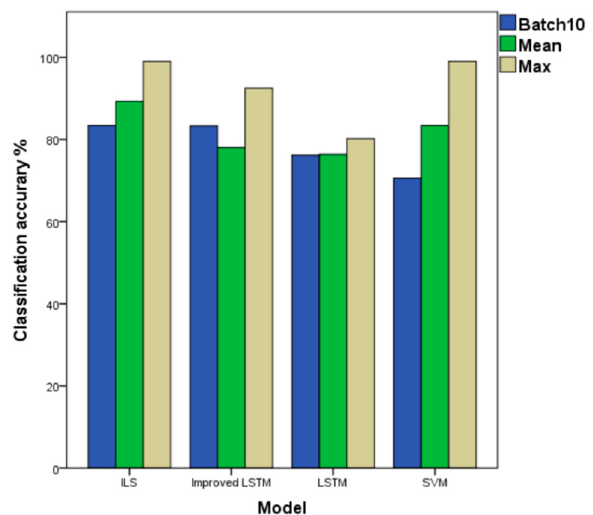
Figure 12. Classification Accuracy of ILS Models and other Models. Green: the highest classification accuracy in every dataset; Blue: the average classification accuracy in every dataset; Brown: the result of batch 10 as a test set in every dataset.